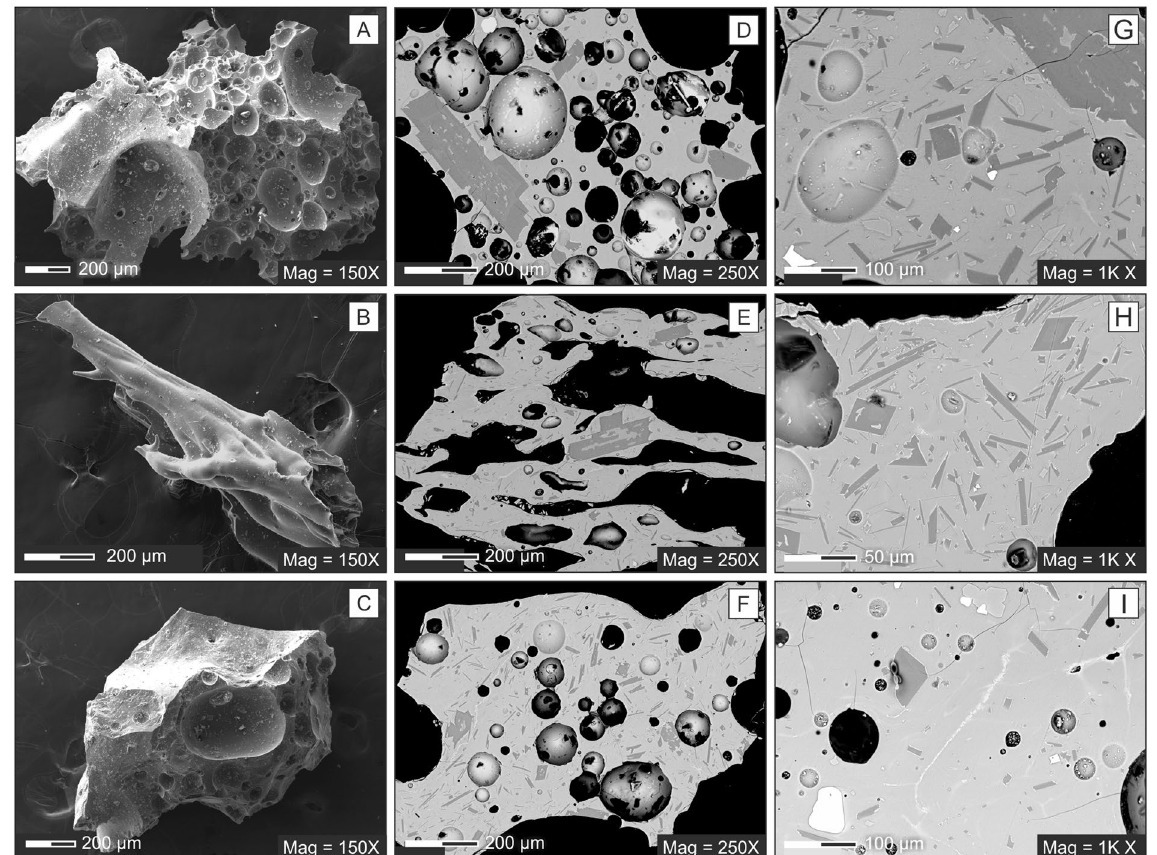
Figure 2. SEM images of ash fractions showing the external morphology of clasts (A = spongy, B = fluidal, C = blocky), vesicularity (D = moderate, E = poor, F = incipient), groundmass crystallinity (G = highly crystalline, H = moderately crystalline; I = poorly